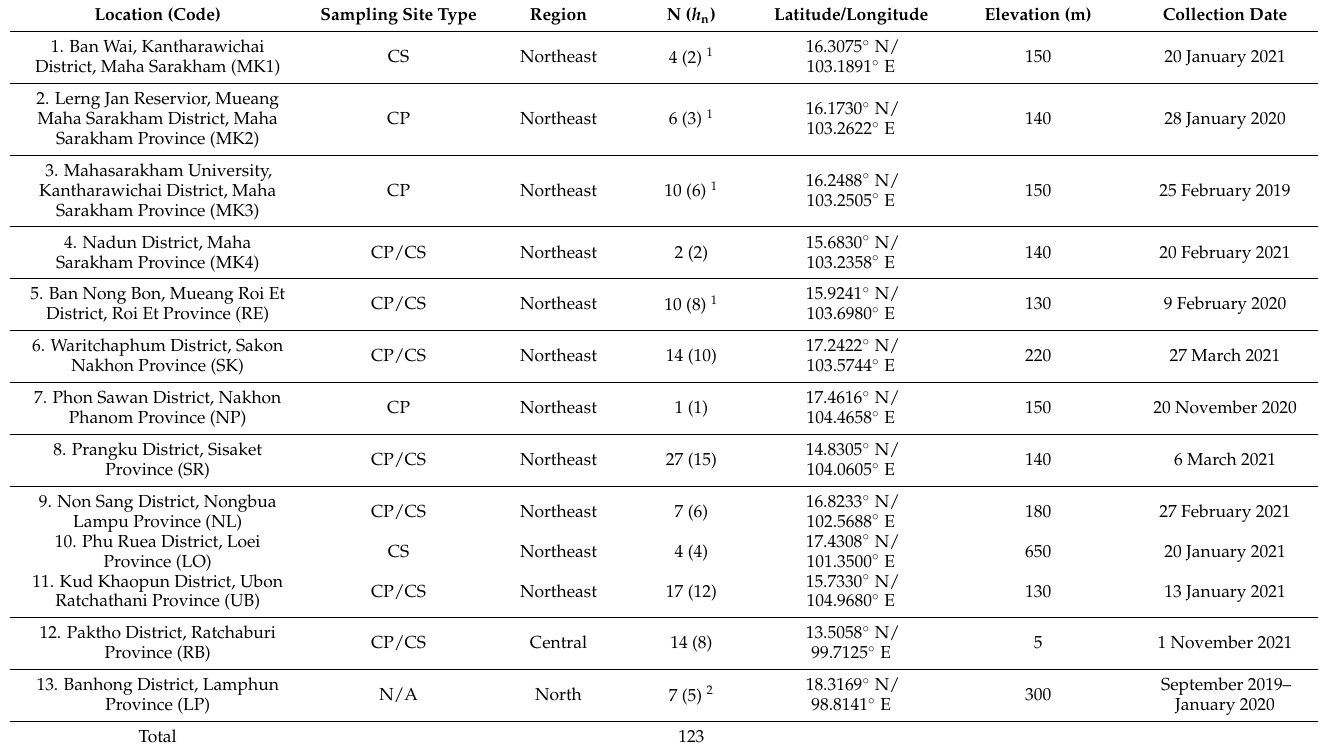
Table 1. Sampling locations of Culicoides mahasarakhamense specimens in Thailand used in this